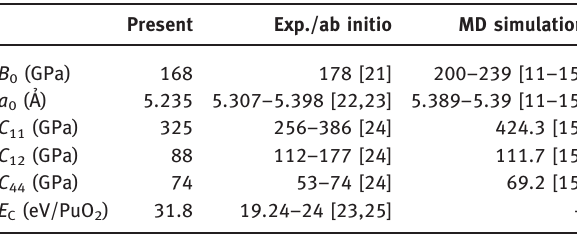
Table 2: Comparison of calculated results with MD simulation, experimental and ab initio data.